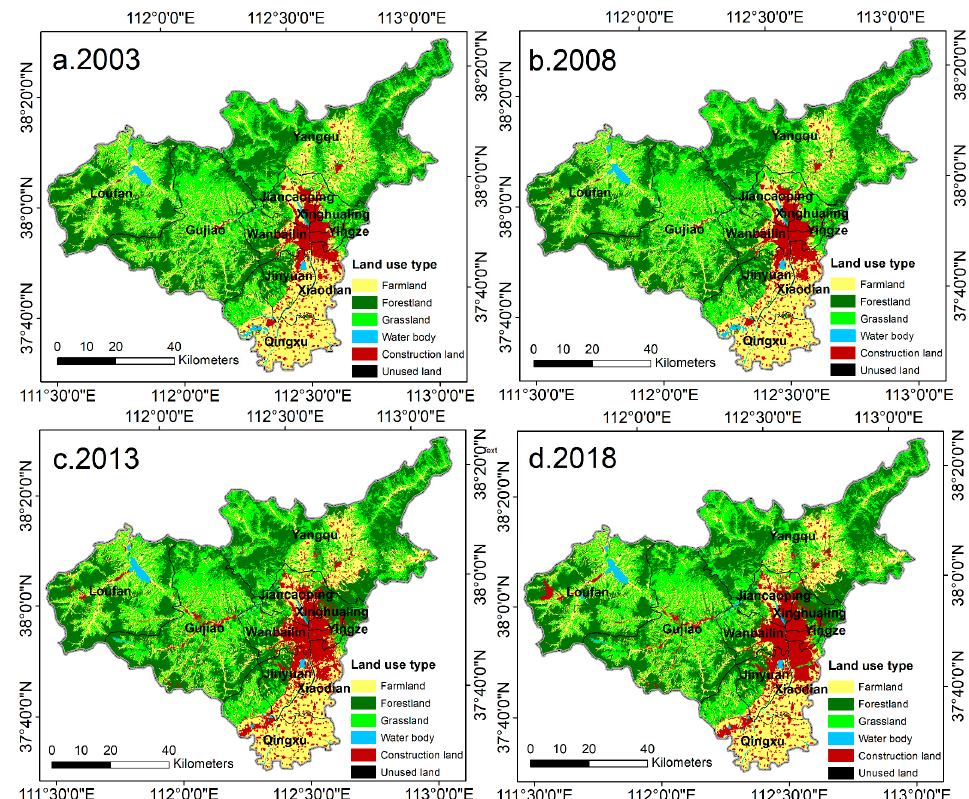
Figure 2. The land use classification maps of Taiyuan in 2003–2018.